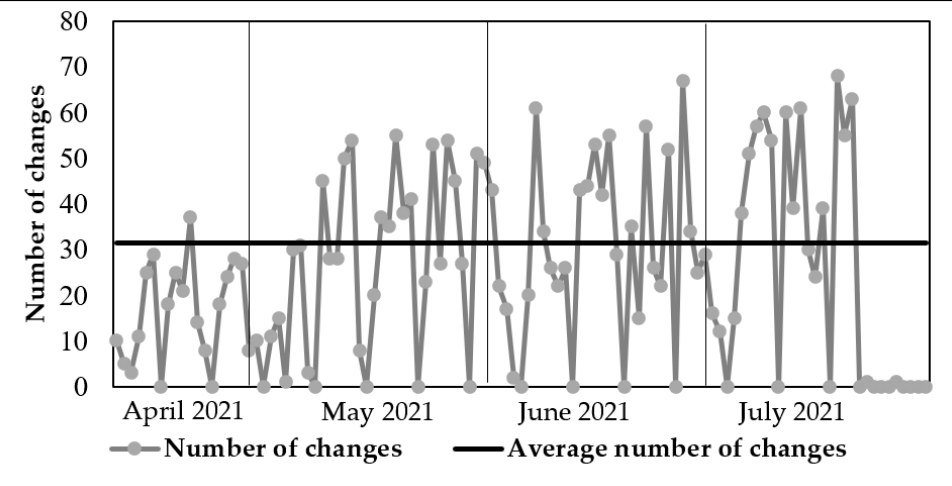
Figure 6. Number of changeovers in Variant 2.